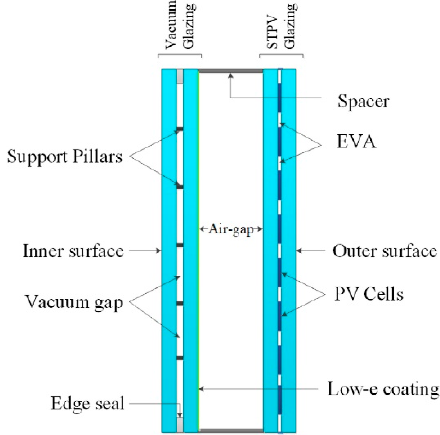
Figure 24. Example of PV combined hybrid vacuum glazing system [67].